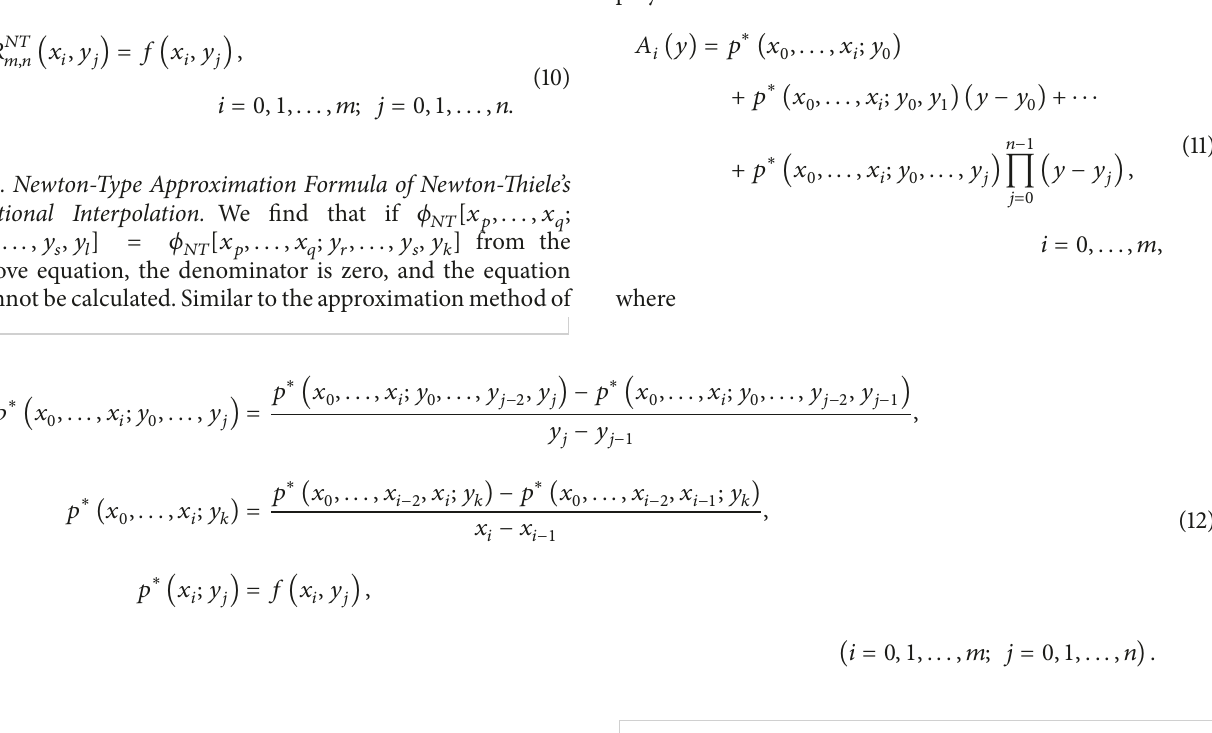
Algorithm 2. The implementation of Algorithm 2 is based on the result of Algorithm